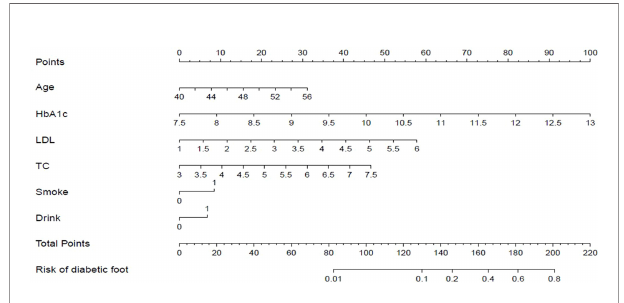
FIGURE 2 | Nomogram prediction for the risk of diabetic foot in patients with T2DM.